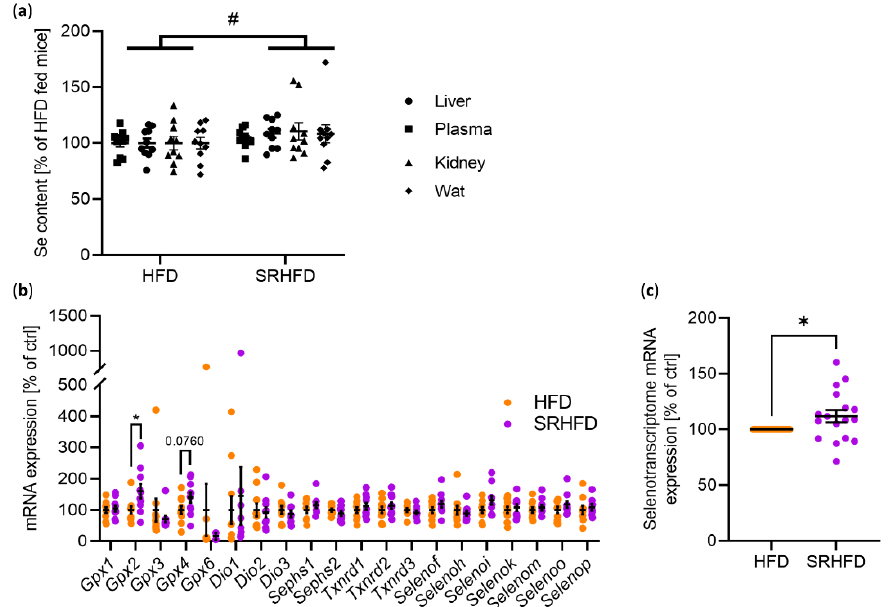
Figure 3. Selenite shows only a mild effect on selenium or selenoprotein contents. ( a ) Total Se con- tent in plasma, liver, kidneys, and WAT, expressed as percent increase relative to the HFD-fed group. ( b ) mRNA expression of selenoproteins in gWAT of male C57BL/6N mice fed either HFD or SRHFD for 10 weeks after established obesity. ( c ) Aggregated selenoprotein mRNA expression from ( b ). *: p < 0.05 after two- tailed Student’s t -test. #: p < 0.05 after two-way ANOVA. All data are presented as mean ± SEM.